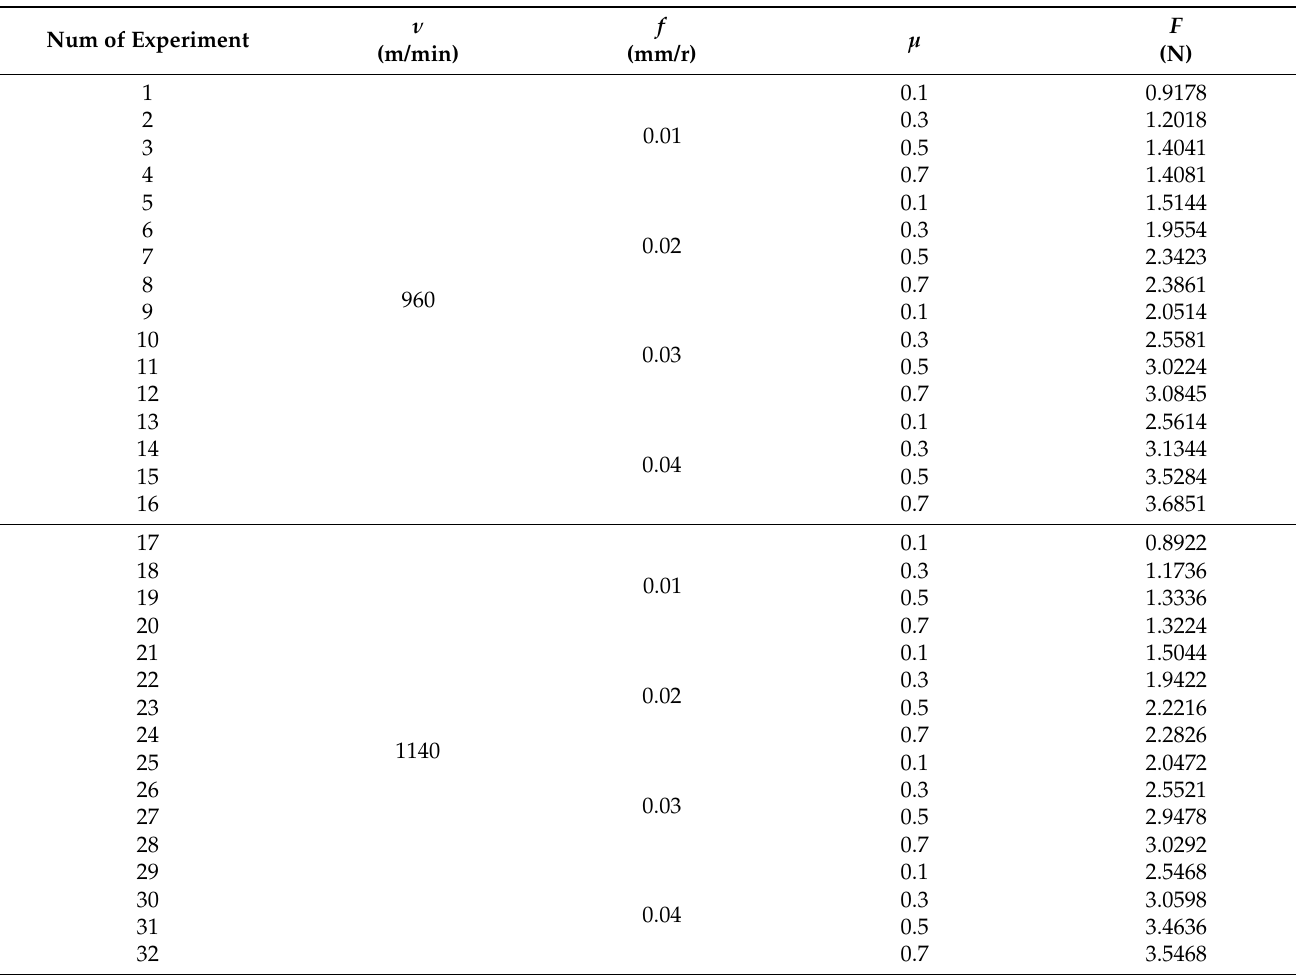
Table A1. Results of the virtual